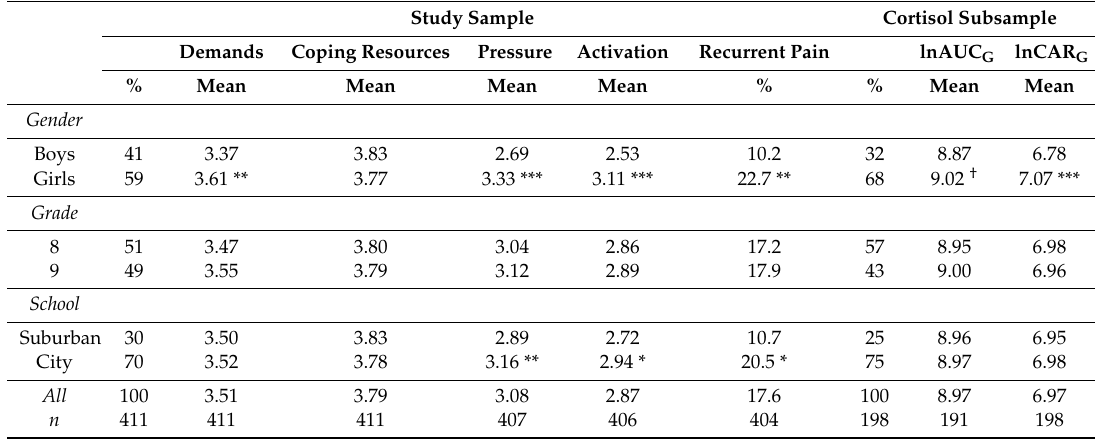
Table 1. Descriptive statistics of the sample and study